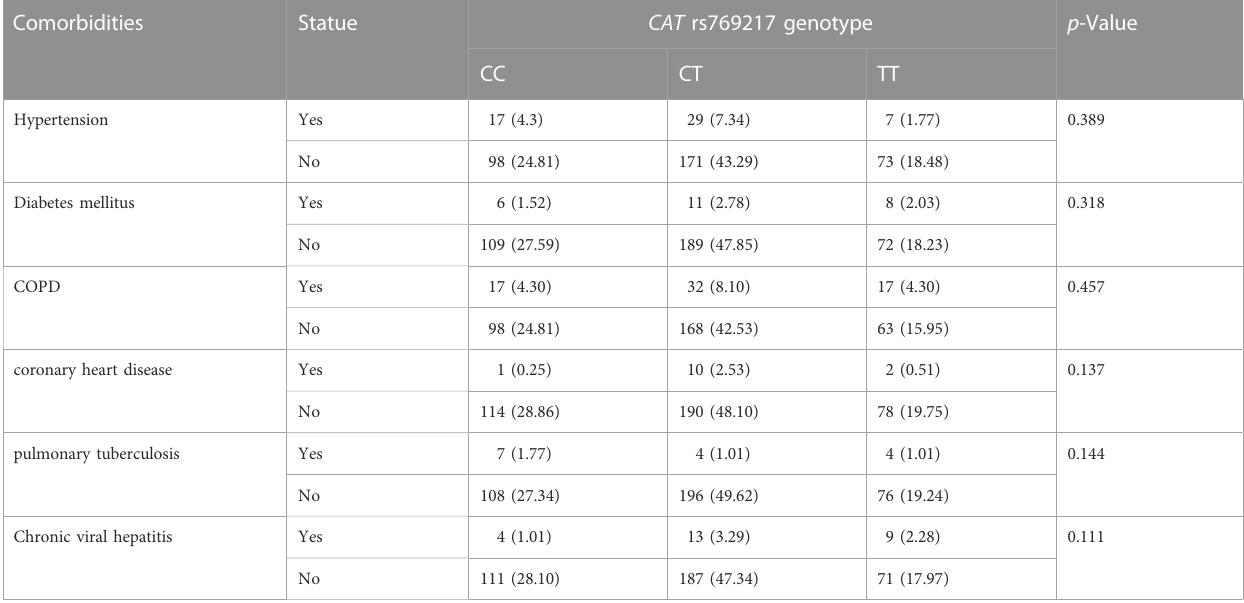
TABLE 1 Association of comorbidities with CAT genotypes in lung cancer patients. Comorbidities